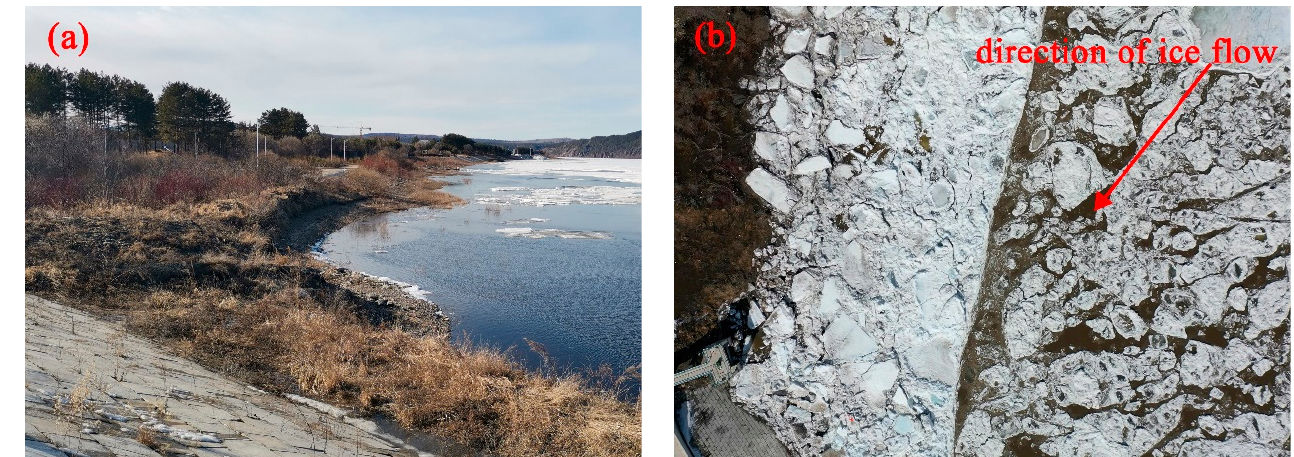
Figure 10. The photo of the right bank ( a ) before ice flood period, ( b ) during ice flood period.